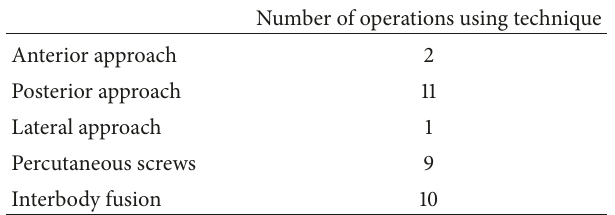
Table 1: Approaches and techniques used in minimally invasive operations.